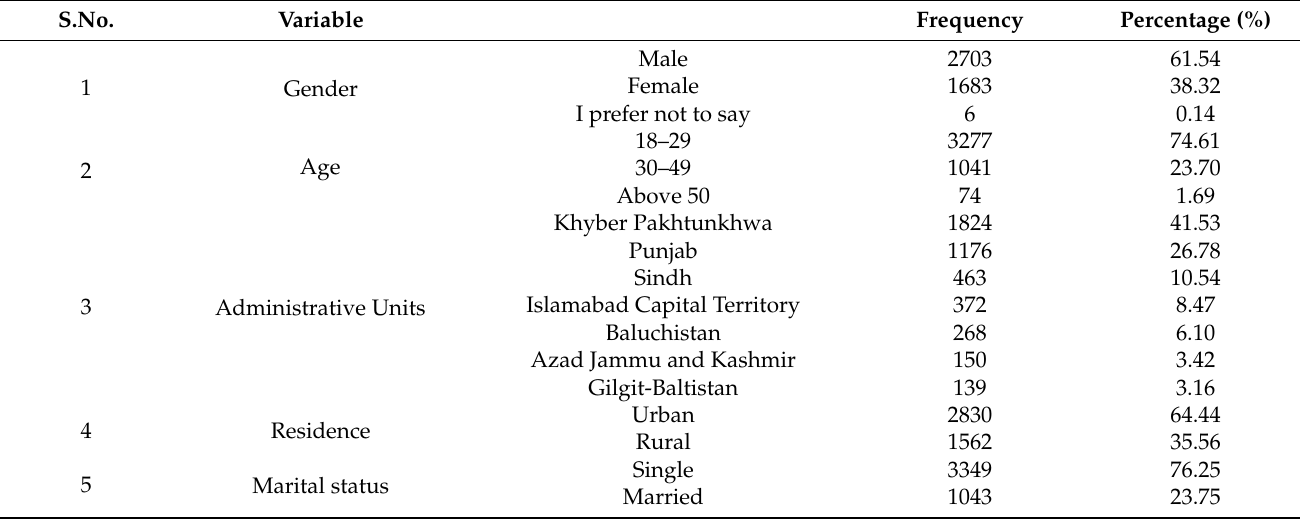
Table 1. Demographic characteristics of the study population ( n =